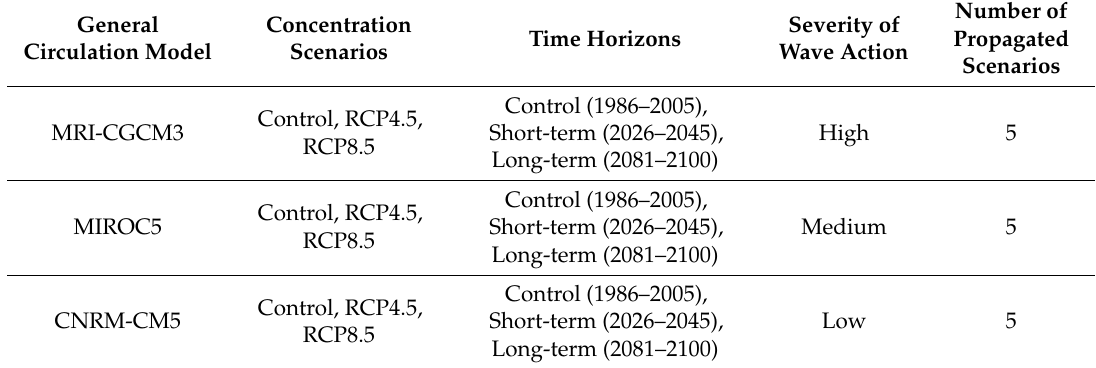
Table 1. Models, concentration scenarios, and time horizons selected for the present